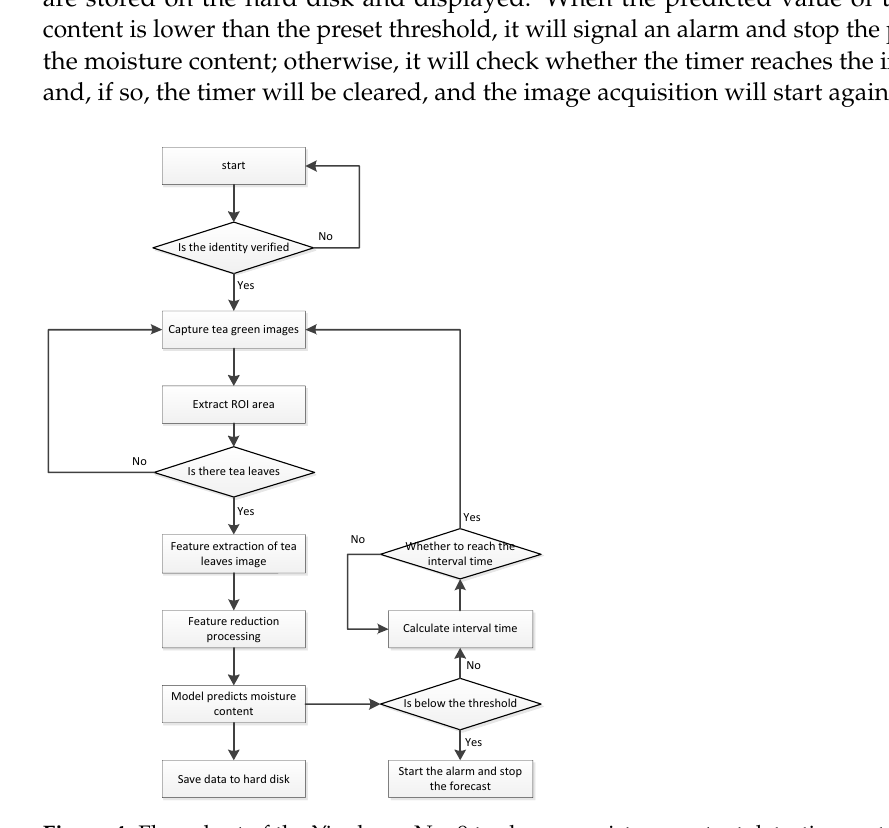
Figure 3. Yinghong No. 9 tea leaves moisture content detection prototype: (1) Control room; (2) dark room.